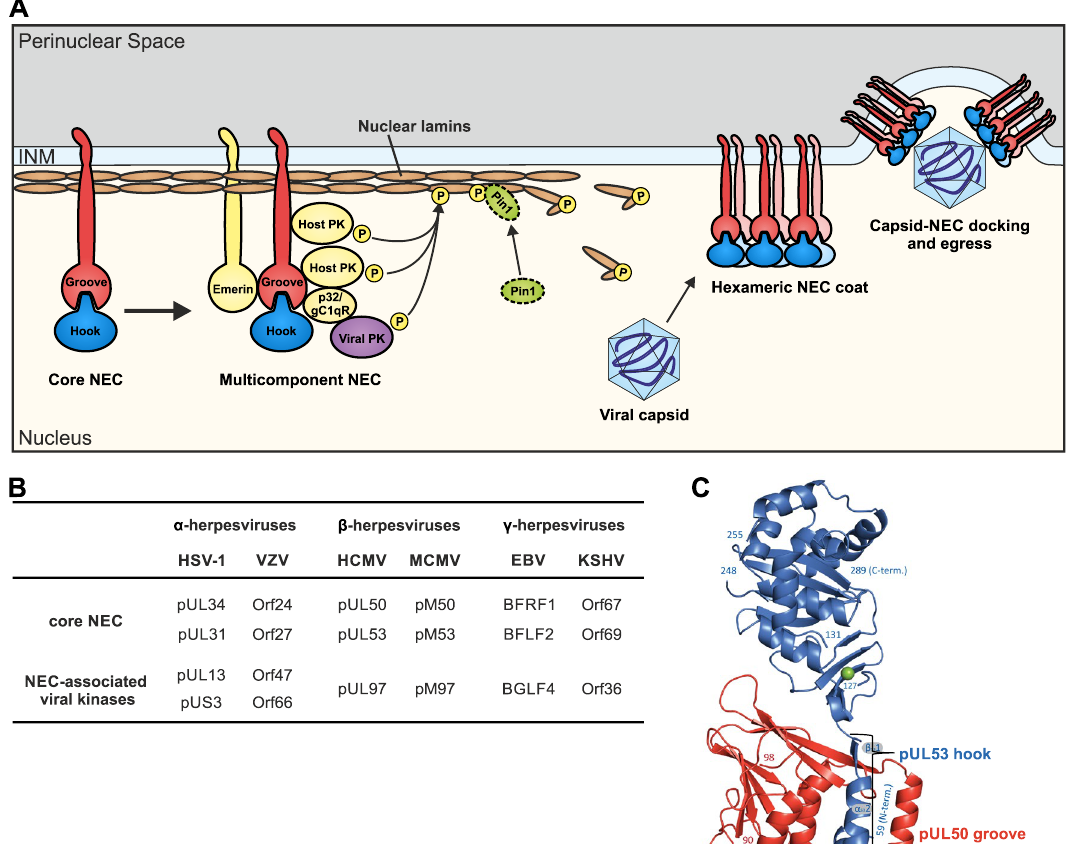
Figure 2. Schematic representation of the nuclear egress and the conserved herpesviral core NEC proteins. ( A ) The herpesviral core NEC is formed by two interacting viral proteins, the hook and the groove protein, which recruit several cellular and viral proteins, in particular protein kinases (PKs), resulting in the multicomponent NEC. At present, it is still unknown whether host PKs may replace the role of viral PKs (note that kinase-negative viral mutants are still moderately replication competent). The local disruption of the lamina network depends on site-specific phosphorylation (P) of nuclear lamins A/C and is mediated by PKs and the isomerase Pin1. The resulting lamina-depleted areas (LDAs) and the oligomerization of the core NEC heterodimers into hexameric rings facilitate the lamina transition and the budding of capsids through the inner nuclear membrane (INM; modified from [35] ). ( B ) Conserved core NEC proteins and NEC-associated viral protein kinases of six herpesviruses (exemplarily, the NEC association was clearly validated for HCMV pUL97, and is likewise postulated for other herpesviral PKs): VZV, varicella zoster virus; KSHV, Kaposi’s sar- coma-associated herpesvirus. ( C ) Crystal structure of the HCMV-specific heterodimeric core NEC characterized by the hook structure of pUL53 (blue) binding into the groove structure of pUL50 (red); modified from [33] . 3. Multiple Viral and Host Components Can Be Associated with Nuclear Egress Complexes 3.1. Herpesviral Multicomponent NECs Represent Assembly Platforms That Recruit a Variety of Nuclear Proteins with Regulatory Activities The core NEC is associated with several viral and host components forming the mul- ticomponent NEC. Thus far, the exact composition of this complex is poorly understood. However, in the case of HCMV, pUL50 seems to be the multi-interacting determinant me- diating the formation of the multicomponent NEC, whereas the functional role of pUL53 still remains largely unresolved. However, there are experimental indications that pUL53 may be involved in the recruitment of the capsids to the NE [36], an initial finding that